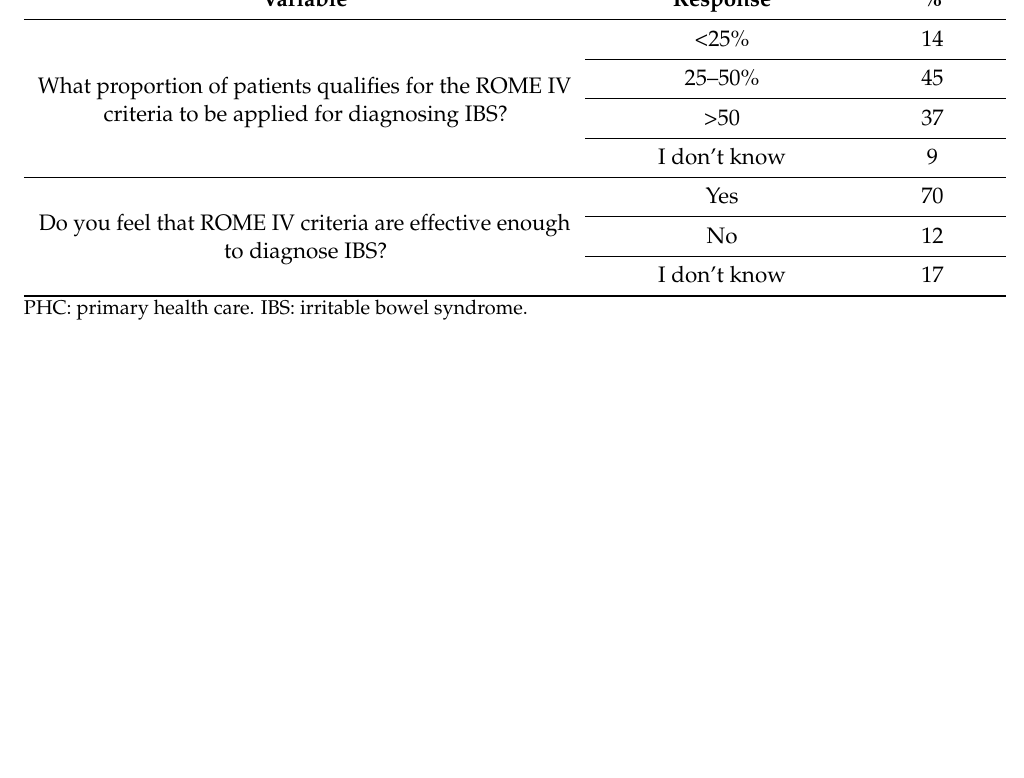
Table 4. Attitude toward ROME IV criteria among PHC physicians. Variable